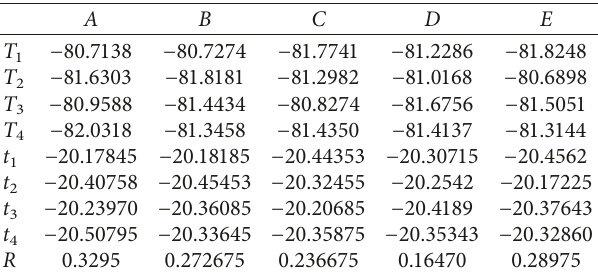
Table 14: T i , t i , and R i of SN ratio at various